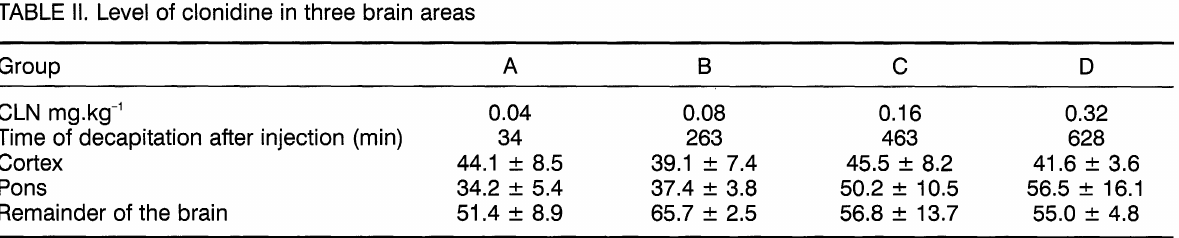
TABLE II. Level of clonidine in three brain areas